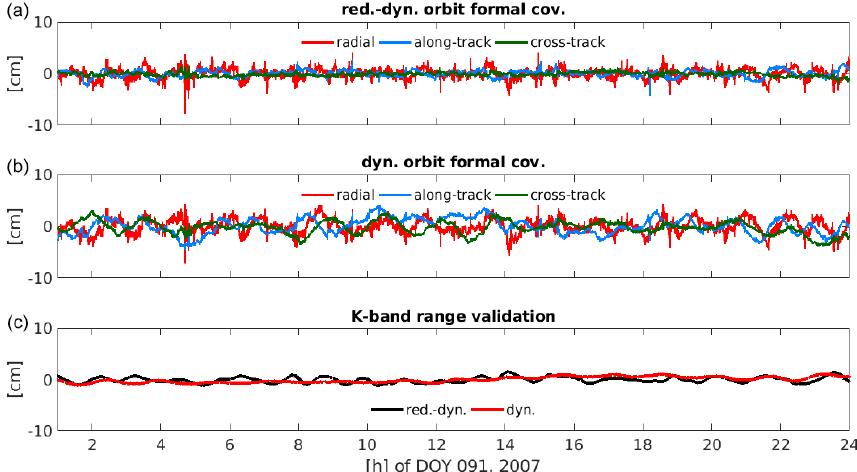
Figure 5. Orbit residuals of GRACE-A using covariances from the formal variance propagation over a period of 50min for day 091, 2007, for the reduced-dynamic orbit (a) , the dynamic orbit (b) and the respective K-band range validation (c) .